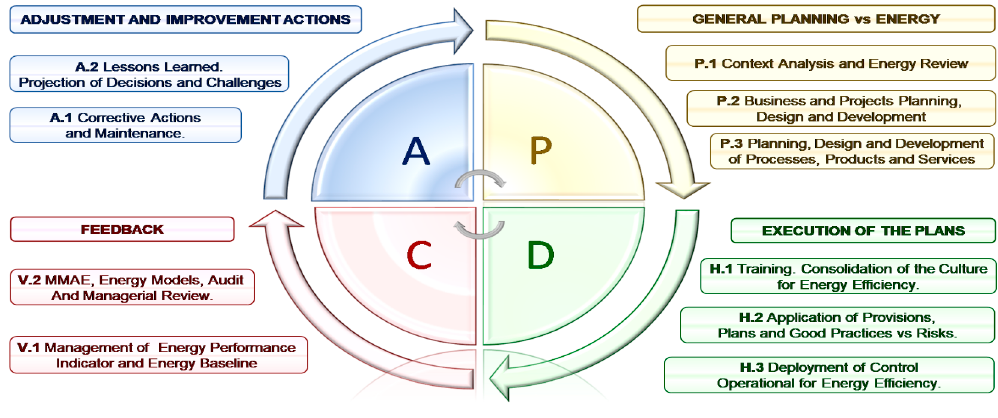
Figure 3. Management approach to energy efficiency [28,52].